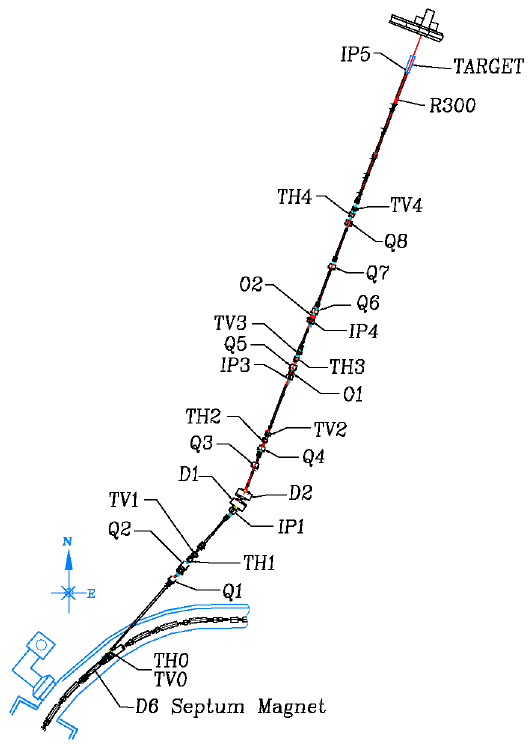
FIG. 2. (Color) The NSRL beam-transport line showing the main magnets (dipoles quadrupoles octupoles) , the corrector magnets (TH, TV) , and the instrumentation packages (IP). The sector appearing at the bottom of the figure is part of the Booster synchrotron